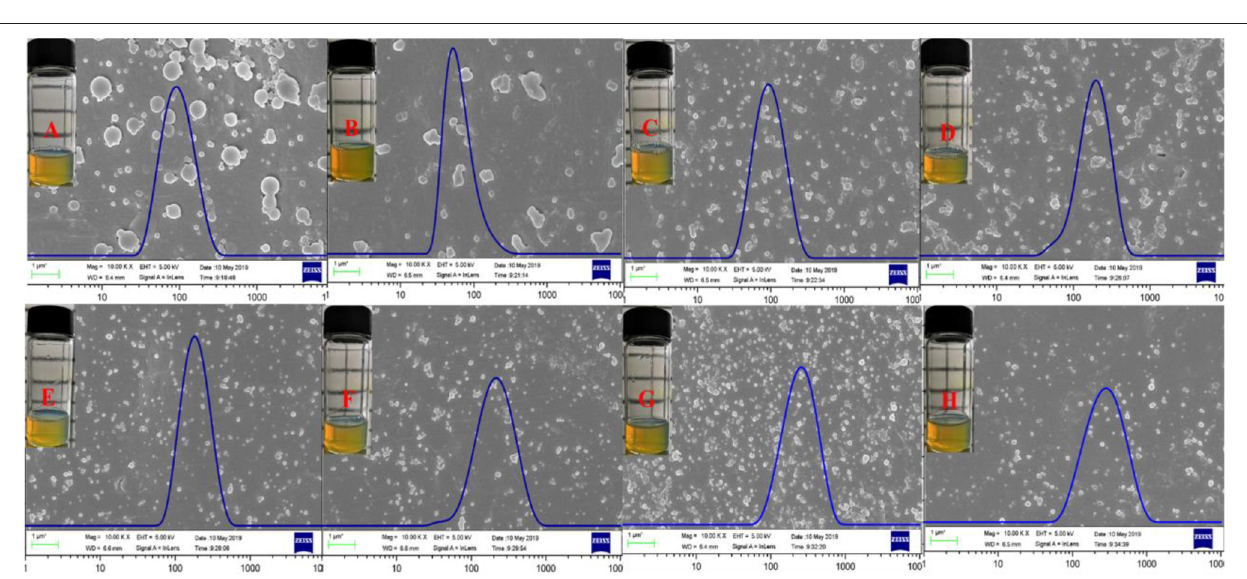
FIGURE 5 | FE-SEM images, size distribution, and optical photography of Zein (A) , Zein-Que (120:6) (B) nanoparticles, and Zein-Que-DSS complex nanoparticles with different DSS concentrations [ (C) Zein-Que-DSS (120:6:5); (D) Zein-Que-DSS (120:6:25); (E) Zein-Que-DSS (120:6:50); (F) Zein-Que-DSS (120:6:75); (G) Zein-Que-DSS (120:6:5); (H) Zein-Que-DSS (120:6:5)].